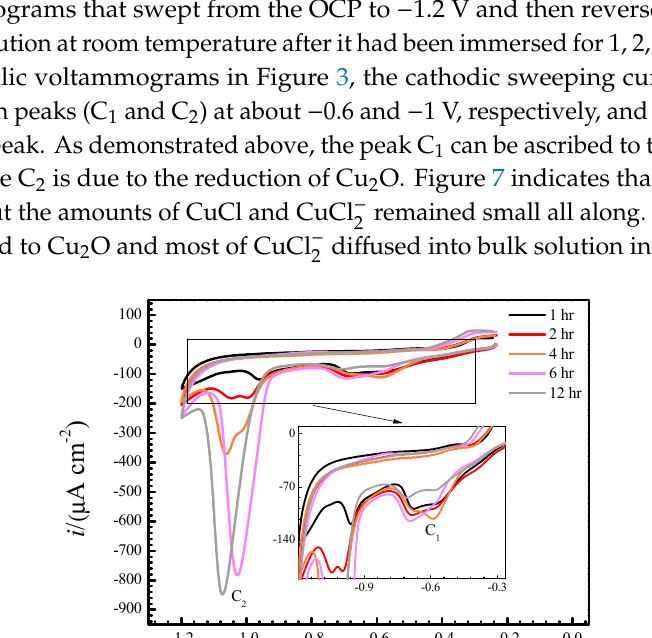
Materials 2019 , 12 , x FOR PEER REVIEW